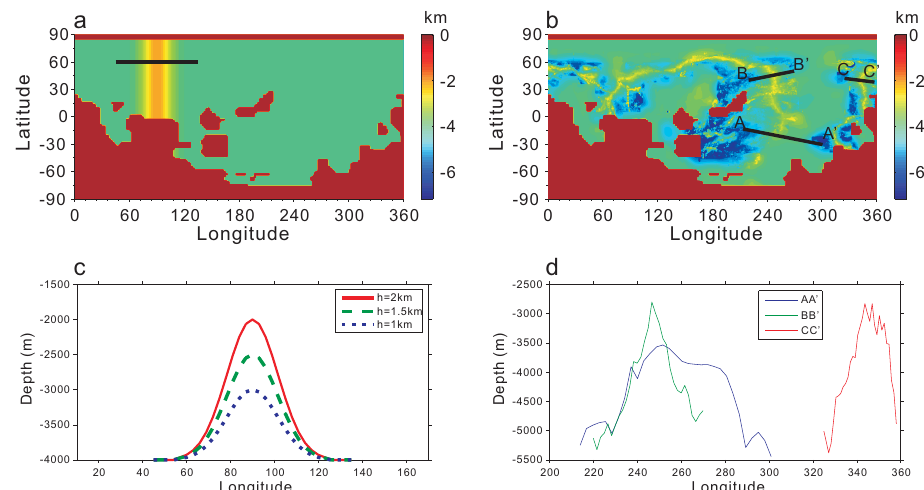
Fig. A1. Ocean bathymetry for 570Ma with (a) simple straight and (b) present-day (with north and south flipped) mid-ocean ridges added. The straight ridge assumes the shape of a Gaussian function, with its width fixed, but the height may vary from among 1.0, 1.5 and 2.0km, as shown in (c) . The shape and heights of the cross section of present-day ridges are shown in (d) . The patches in dark red color in (a) and (b) are the